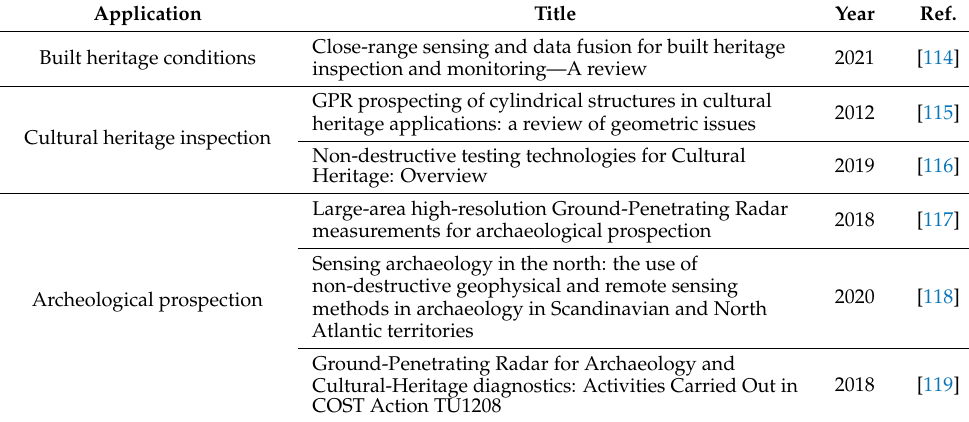
Figure 2. Examples of GPR application in archeology and cultural heritage: 500 MHz overlaid time-slice to detect buried remains at the Roman Site “ Aquis Querquennis ” ( a ), 500 MHz 3D cube and volumetric reconstruction of an ancient underground tunnel ( b ), and 2.3 GHz and 1.2 GHz data to detect internal fractures (red lines) in one anthropomorphic grave of the rock necropolis of San Vítor de Barxacova ( c ). Adapted with permission from [112,113]. Author’s own work and Copyright 2014, Elsevier. Table 2. Published review papers in archeological investigations.